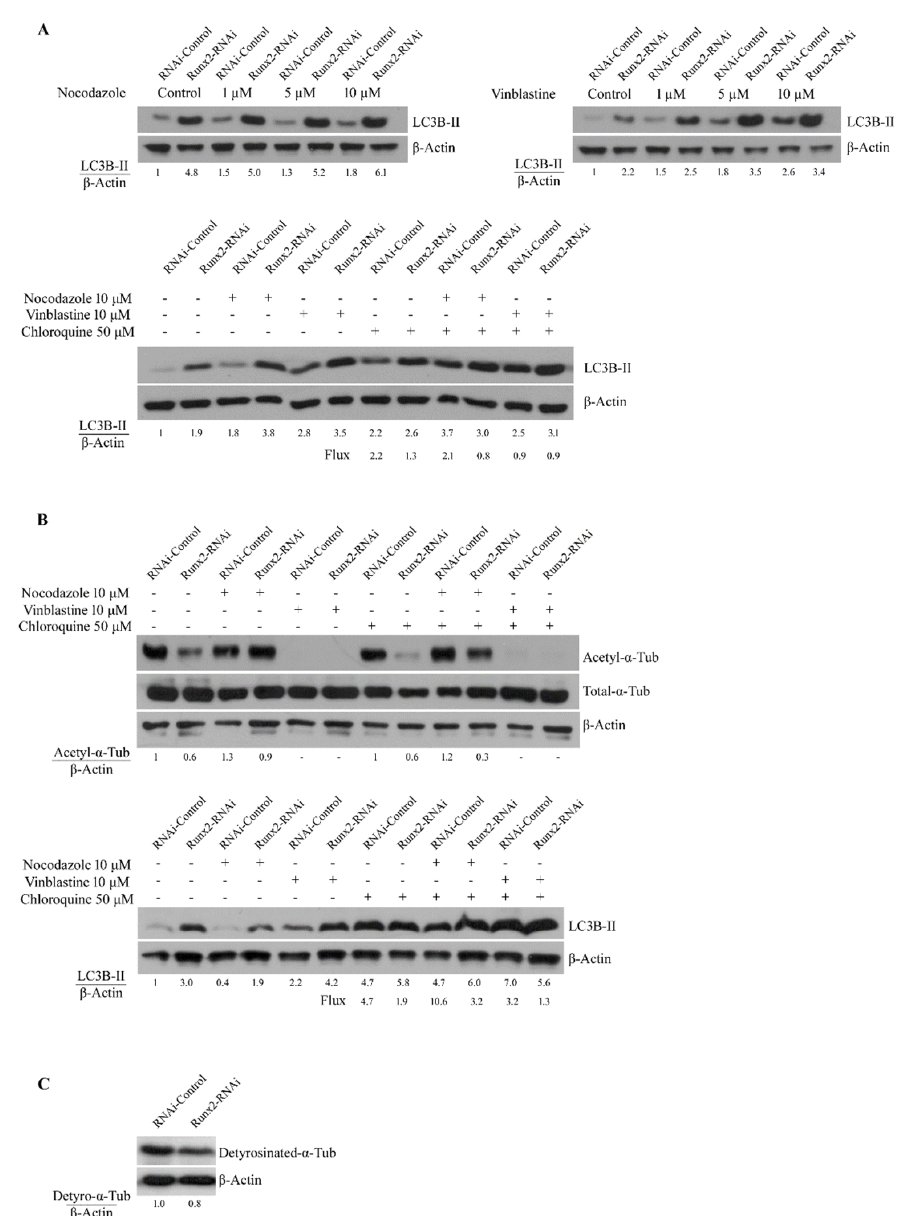
Figure 3. Disruption of stable microtubules impacts autophagy. ( A ) The western blots for LCB-II levels of whole-cell lysates from BoM-MDA-231 control and Runx2 knockdown cells treated with vinblastine and nocodazole. Cells were serum-starved overnight and were then treated with vinblastine and nocodazole for 3 h with indicated doses. The β -actin expression is shown as an internal loading control. ( B ) The western blots for acetyl- α -tubulin (Lys40) levels and LCB-II levels in BoM-MDA-231 control and Runx2 knockdown cells treated with nocodazole and vinblastine and subsequent washout. Cells were treated with nocodazole and vinblastine for 3 h and were then washed with PBS and replenished with standard culture media for an additional 3 h. Chloroquine treatment was present for the full duration of these experiments. Western blots shown are representative of 3 independent experiments. ( C ) Western blots showing the levels of detyrosinated α -tubulin in BoM-MDA-231 control and Runx2 knockdown